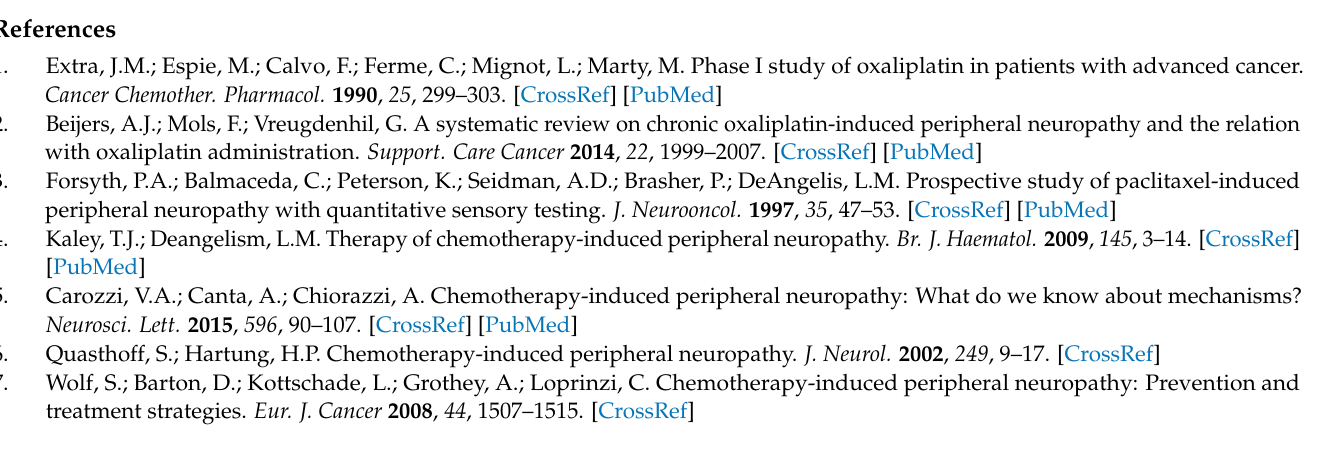
Figure S2: Safety of oxaliplatin, paclitaxel, and duloxetine administrated in vivo, Figure S3: Safety of oxaliplatin, paclitaxel, and PD0325901 administrated in vivo, Figure S4: Full length of western blot analysis for Figures 5 and